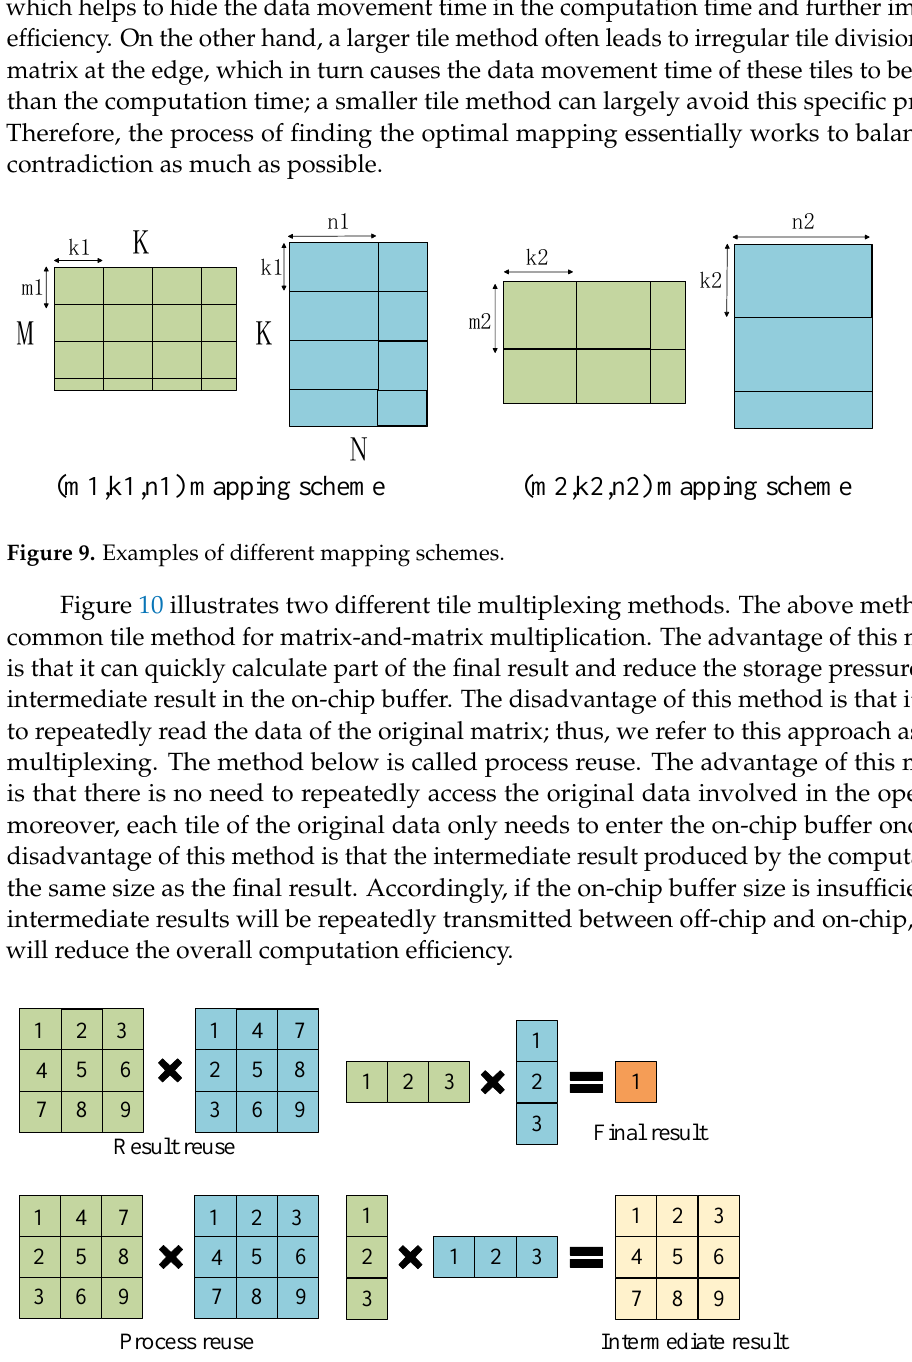
Figure 10. Examples of different tile multiplexing